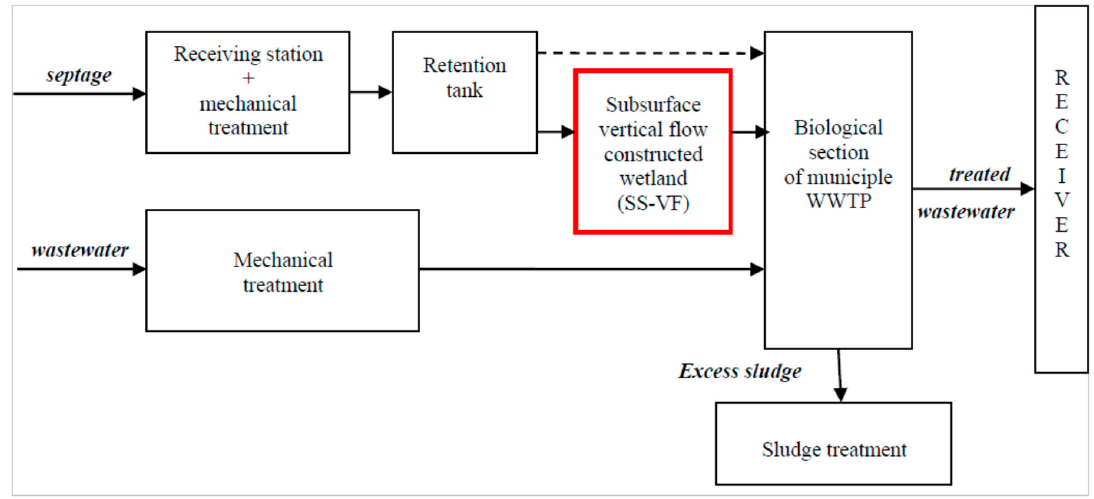
Figure 1. Figure 1. System for wastewater and septage treatment in a municipal wastewater treatment plant (WWTP).